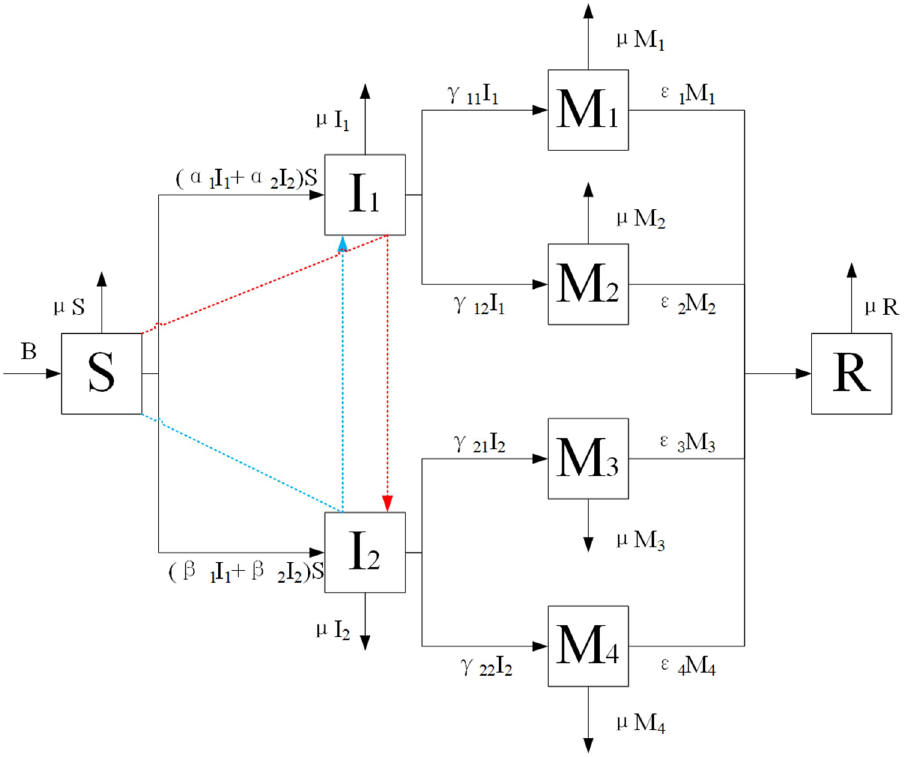
Figure 1. The flow diagram of the